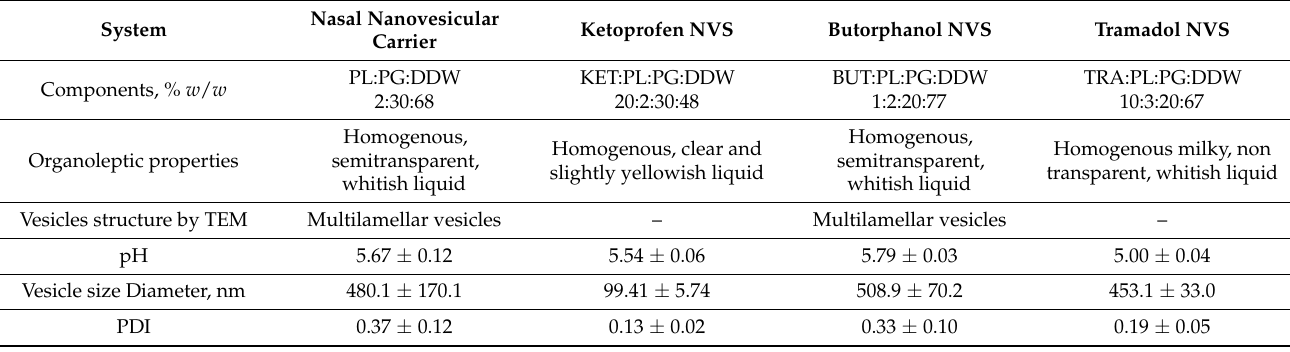
Table 3. Compositions and properties of nanovesicular carrier and selected NVS containing non-controlled drugs for pain management.